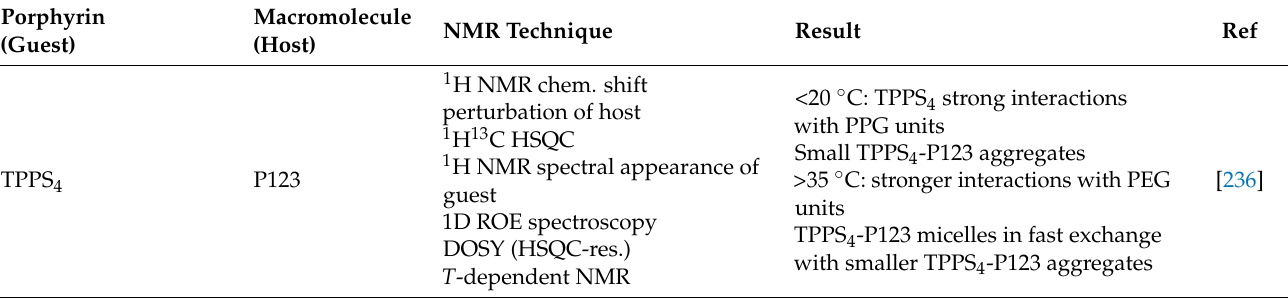
Table 5. Summary of NMR interaction studies between porphyrins and block copolymer micelles. Porphyrin